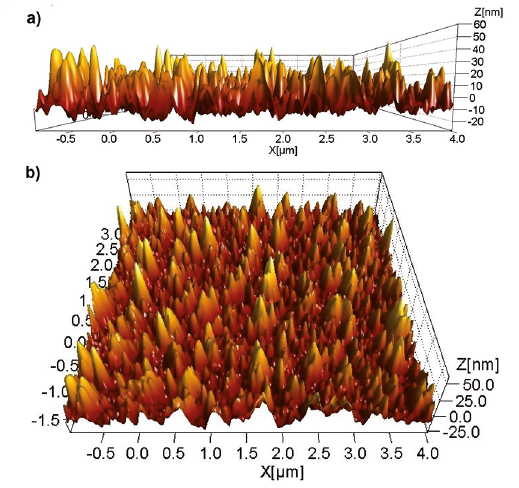
Ga As, scanning by AFM, x x 1-x